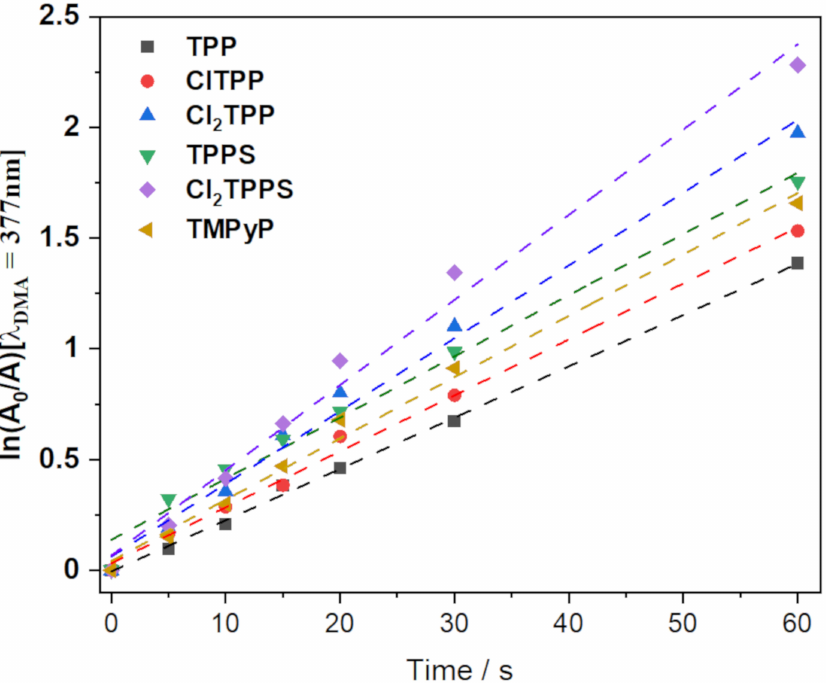
Figure 6. Singlet oxygen quantum yield determination using 9,10-dimethylanthracene (DMA) as a singlet oxygen quencher. There is a decrease in DMA absorption measured in PBS (with 0.5% DMSO) in the presence of porphyrins under the irradiation with visible light using a 420 nm ( ± 20 nm) diode as the light